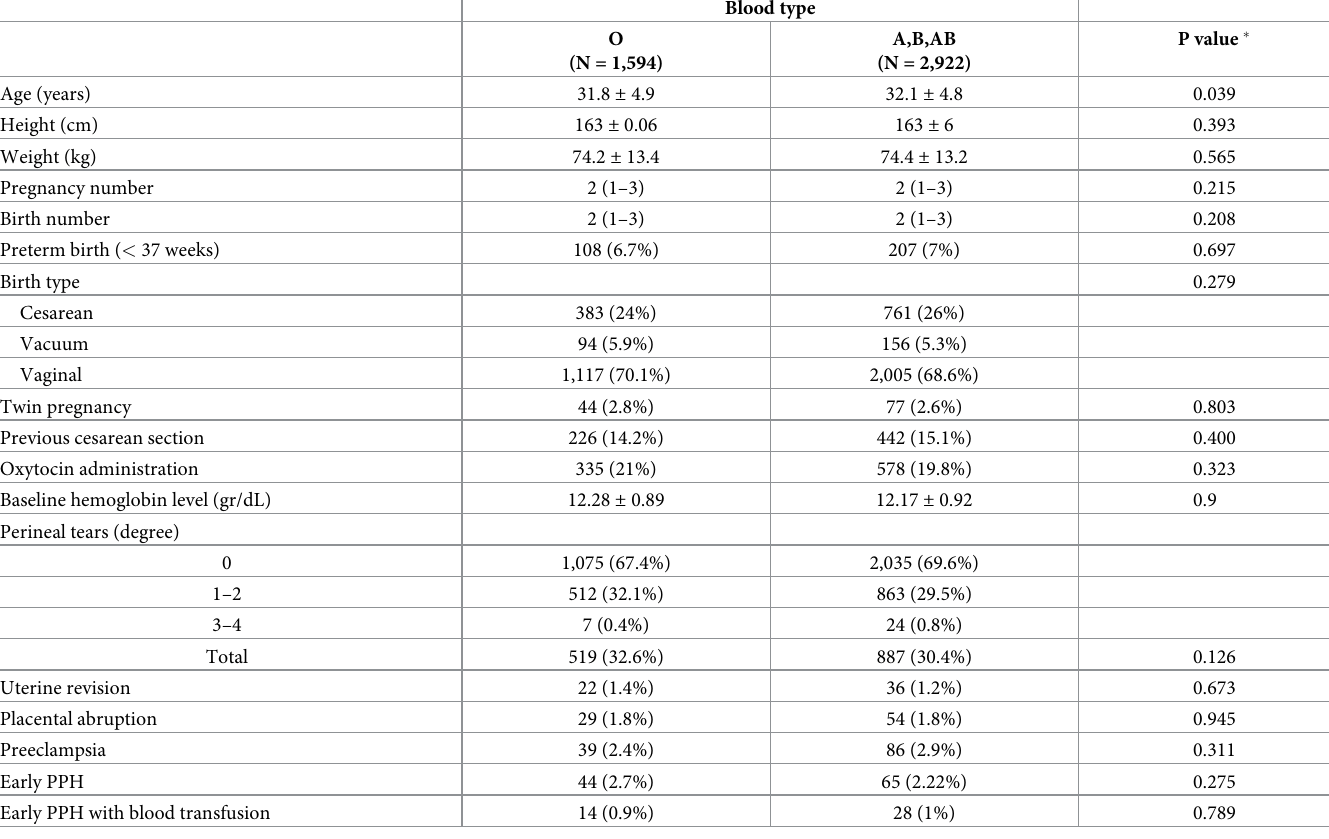
Table 1. Comparison of demographic and clinical characteristics of women by ABO blood type.